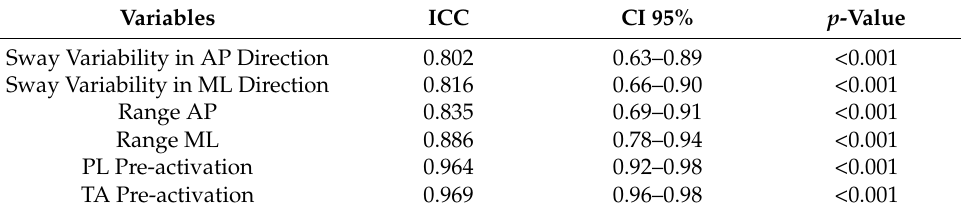
Table 3. The intraclass correlation coefficient (ICC) for all variables. Variables